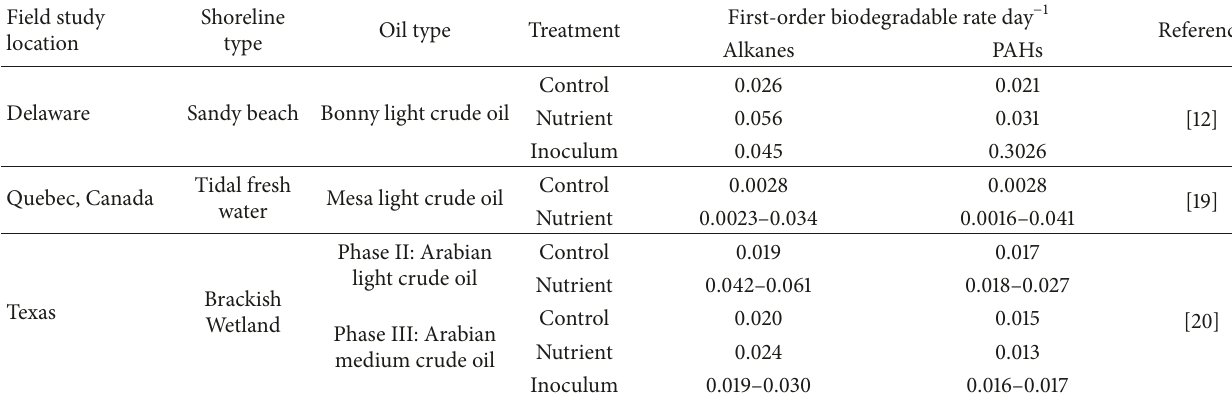
Table 2: Typical first-order biodegradation rate constants from field studies.